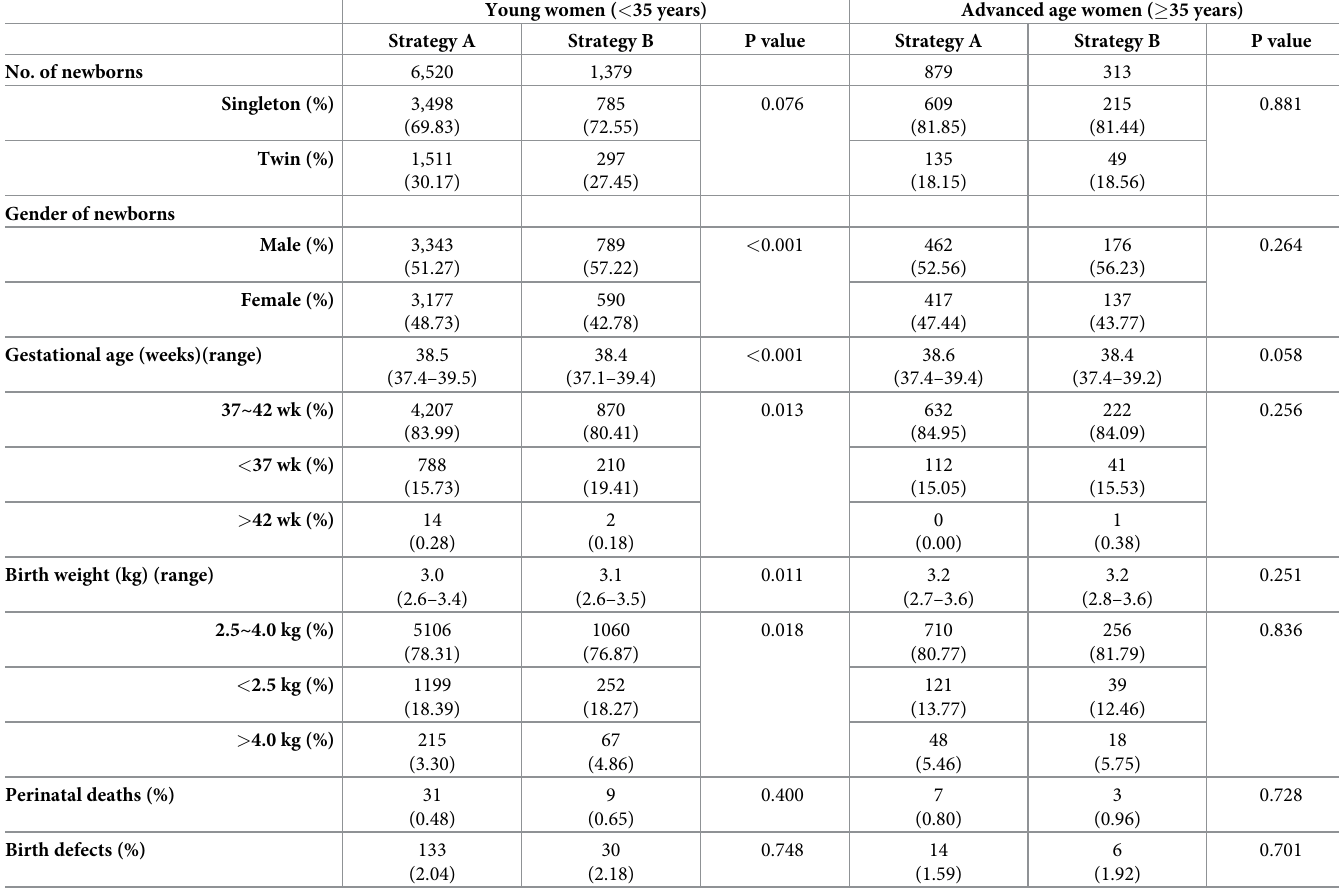
Table 4. Characteristics of newborns born to women of young and advance age who underwent FET via strategies A and